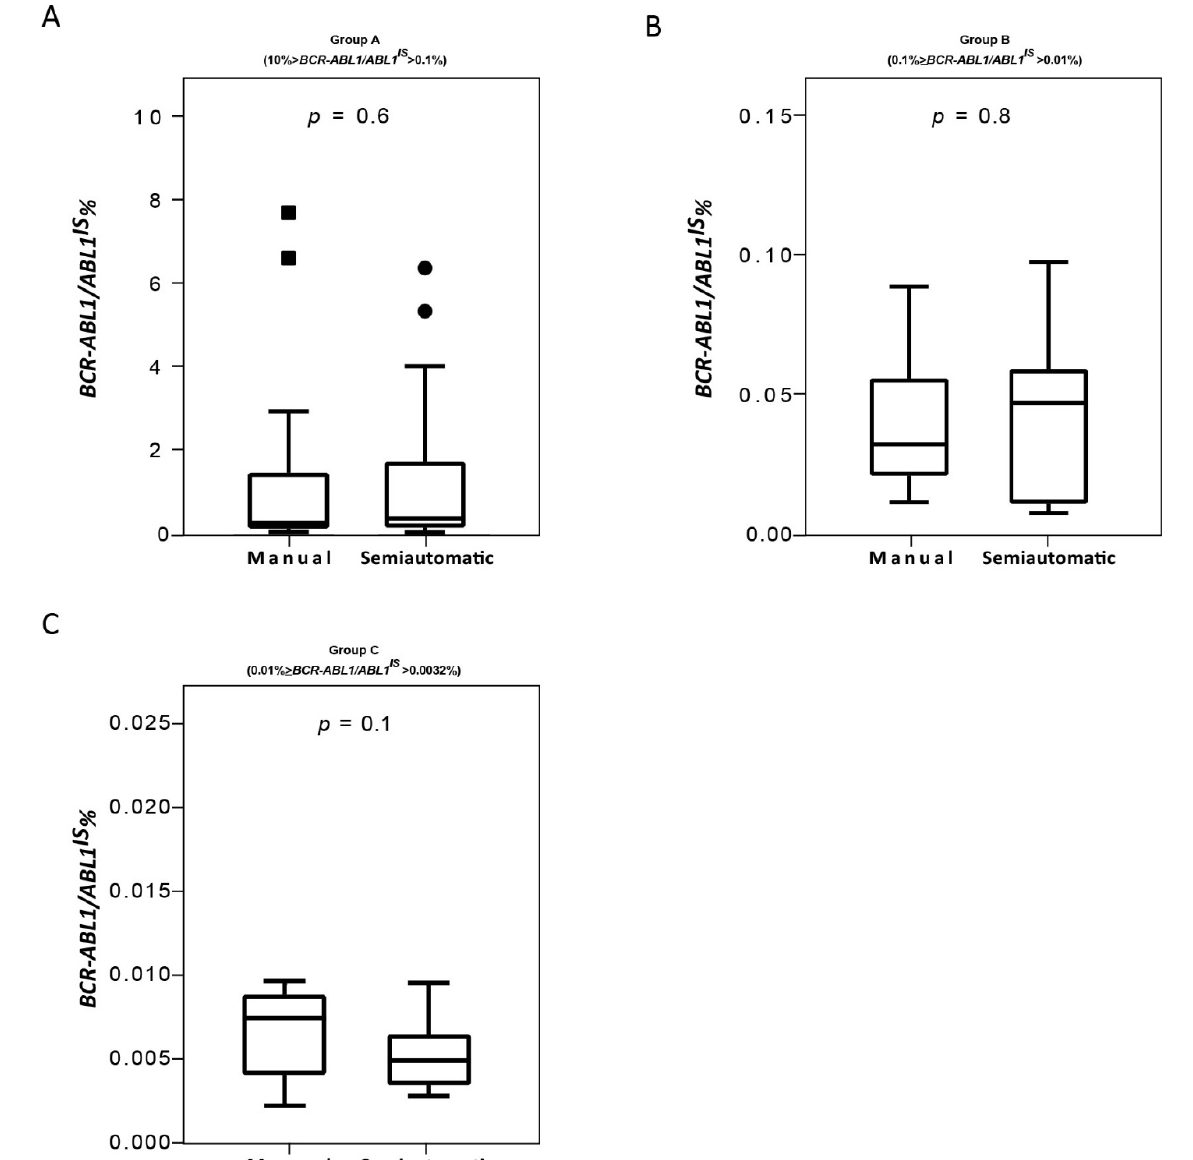
Figure 4. Quantitative PCR performance on samples processed with the manual and semiautomatic protocols . Molecular measurement of BCR-ABL1 transcripts levels by Q-PCR of matched blood samples processed with a manual or a newly semiautomatic method. BCR-ABL1/ABL1 IS had assessed in patients stratified in four groups, each consisting of 25 subjects: Group A (10% > BCR-ABL1/ABL1 IS > 0.1%) ( A ), Group B (0.1% > BCR-ABL1/ABL1 IS > 0.01%) ( B ), Group C (0.01% > BCR-ABL1/ABL1 IS > 0.0032%) ( C ). BCR-ABL1/ABL1 IS levels were determined for each method and depicted as boxplots delimited by the 25th (lower) and 75th (upper) percentile. Horizontal lines above and below each boxplot indicate the 5th and 95th percentile, respectively. Thick lines in each boxplot represent median BCR-ABL1/ABL1 IS in each patient group. The Wilcoxon signed-rank test was used to test thedifference between the platforms. The symbols ▪ and ● indicate the manual and the semiautomatic method, respectively. A p value below 0.5 was considered statistical significant.